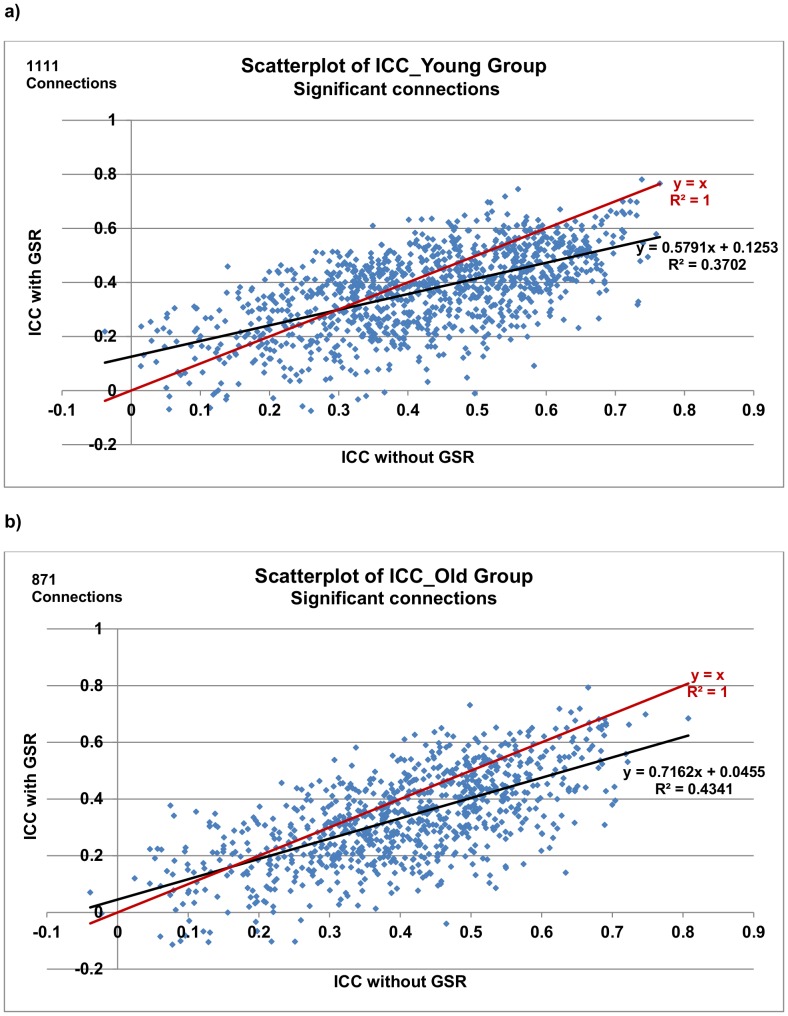
Scatterplot of ICC for connections with vs. without GSR.GSR tends to reduce the reliability of connections (i.e., regression lines are under y = x when ICC >0.3 for the young group and ICC >0.15 for the old group). Each data point indicates a significant connection from each group. Black lines represent linear regression fits of the data and red lines represent y = x.